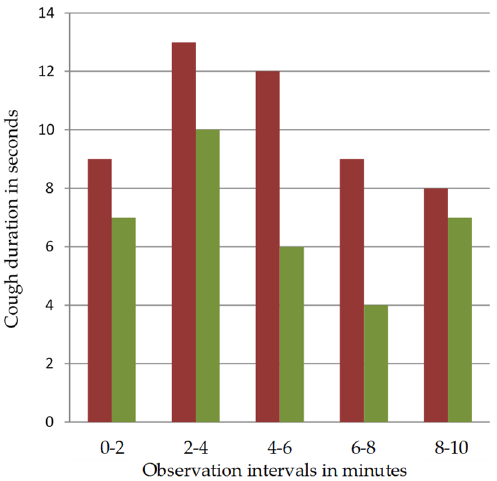
Figure 2. Development of median cumulative cough duration in 2-min intervals during the 10 min recording time. Median cumulative cough duration is shown in seconds for both Standards (S1 (+LAP)—red columns, S2 ( − LAP)—green columns) for the respective intervals.